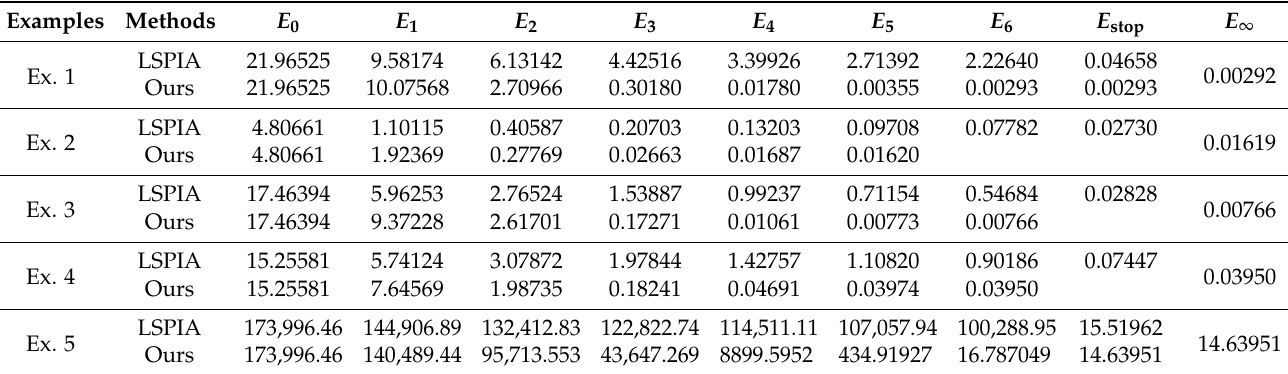
Table 1. ( k = 0, 1,..., 6), E stop and E ∞ for examples